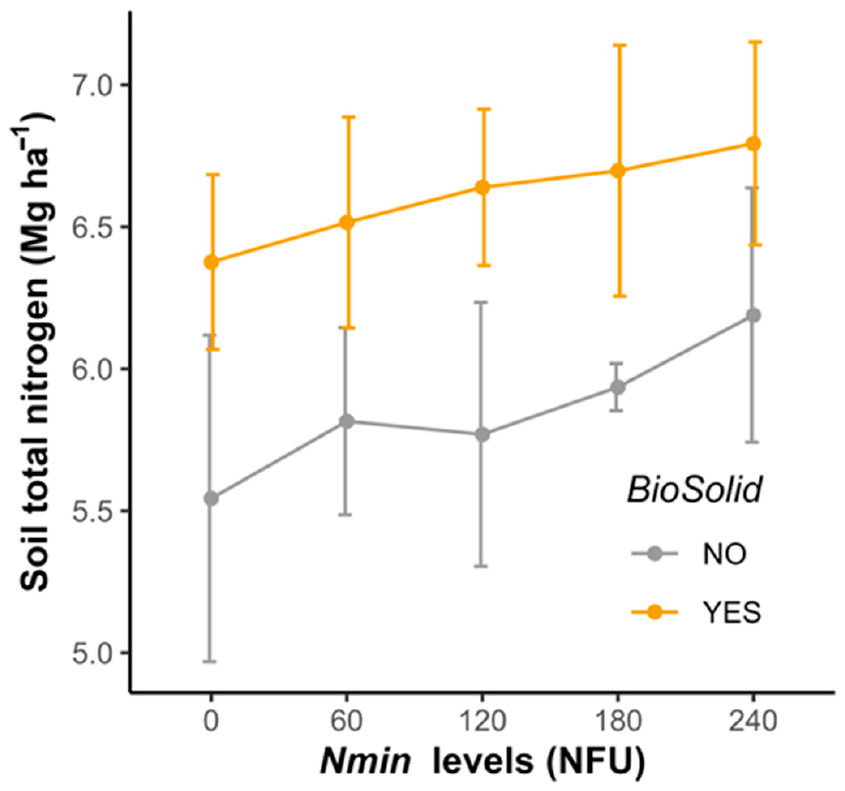
Figure 3. Soil total nitrogen (Mg ha − 1 ) as a function of the Nmin and BioSolid levels. Error bars show 1 standard deviation of 4 replicated data.